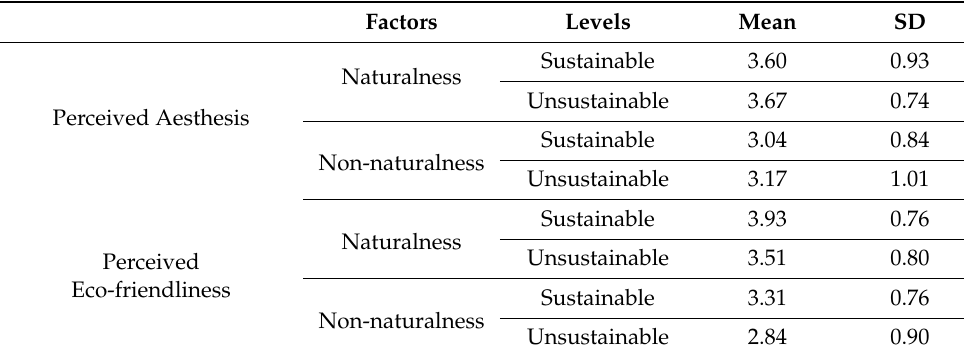
Table 2. Summary of descriptive analysis of different factors.